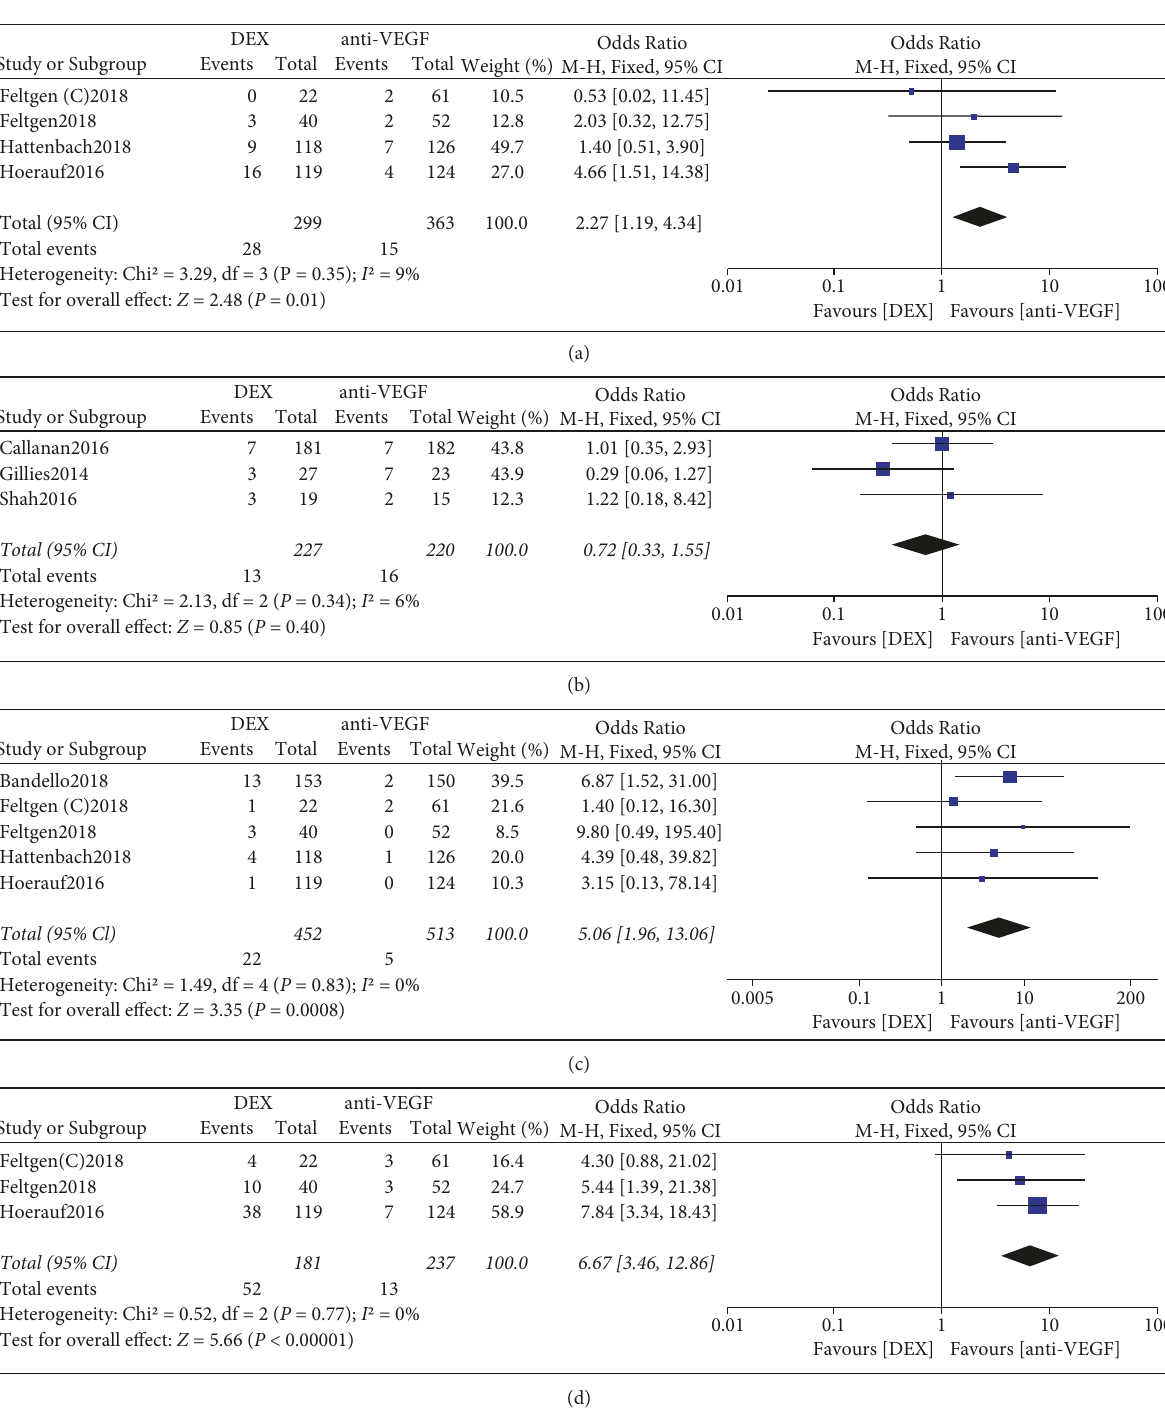
Heterogeneity: Chi2 = 0.52, df = 2 ( P = 0.77); I 2 = 0% Test for overall effect: Z = 5.66 ( P < Figure 6: (a) Forest plot of SAEs, (b) conjunctival hemorrhage, (c) cataract or cataract exacerbation, and (d) high IOP for